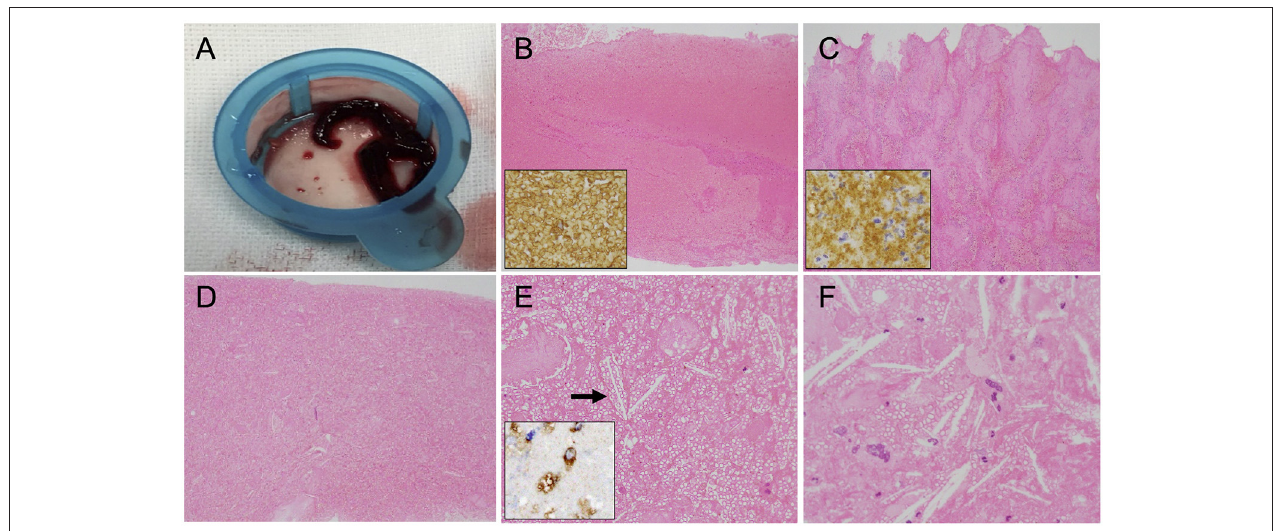
FIGURE 2 | Macroscopic and microscopic findings of the retrieved thrombi. (A) Macroscopic appearance of the retrieved thrombi. (B,C) Histopathological sections showing the erythrocyte-rich thrombus that was immunopositive for anti-glycophorin A (insert) (B) and the platelet-rich thrombus that was immunopositive for anti-glycoprotein IIb/IIIa (insert) (C) . Original magnification × 40. (D) Many cholesterol clefts are distributed throughout this thrombus specimen. Original magnification × 40. (E) Cholesterol clefts ( arrow ) and foam cells in the erythrocyte-rich thrombus. Original magnification × 200. Insert immunohistochemistry with CD68 revealing the presence of macrophages. (F) Necrotic core with aggregation of cholesterol clefts and multinucleated giant cells in the platelet-rich thrombus. Original magnification ×